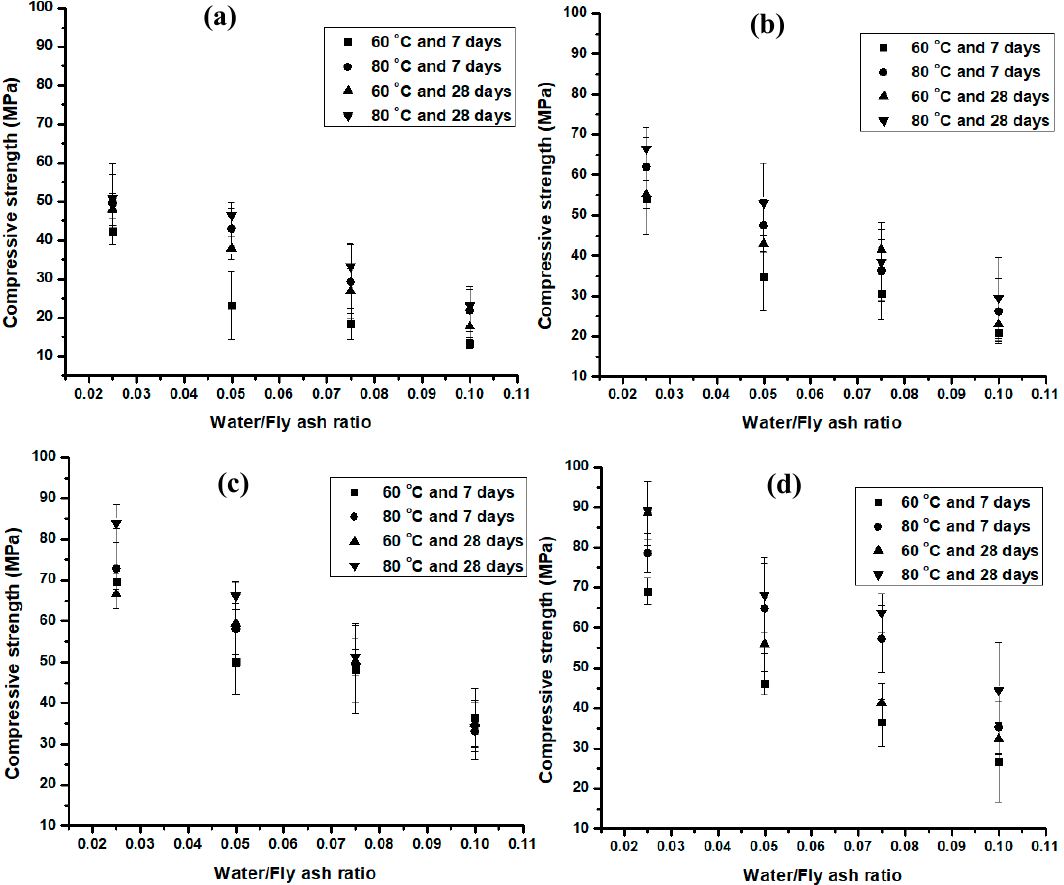
Figure 3. Compressive strength resulting when adjusting different parameters involved in the synthesis of geopolymer, ( a ) 10, ( b ) 12, ( c ) 14 and ( d ) 16 M of NaOH (Fixed parameters were ratio of Na 2 SiO 3 /NaOH = 2.5 and NaOH/fly ash = 0.1 as described in Section 2).